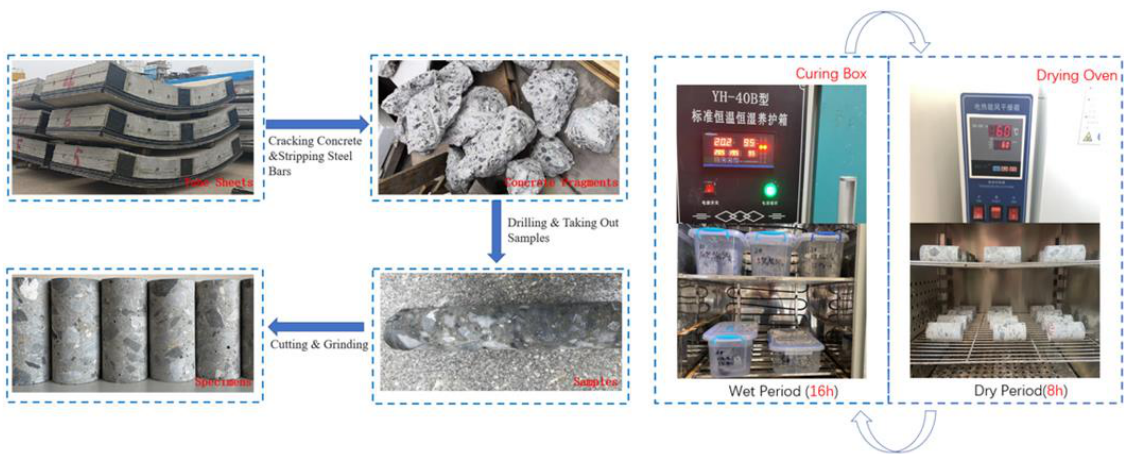
Figure 1. Sample preparation and test. Table 2. Specimen grouping and curing environment.